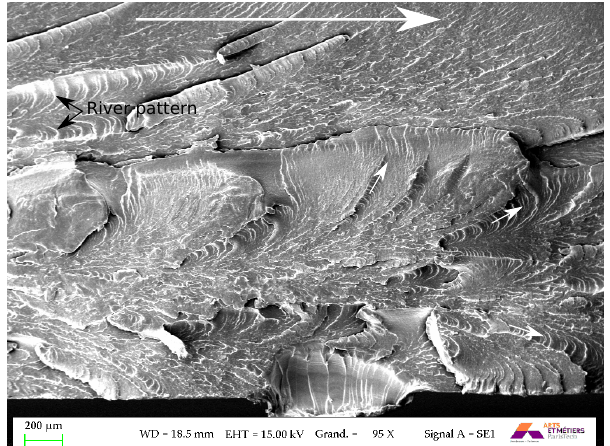
Figure 6. Observation by electron microscopy of the propagation zone of the fracture surface of sample B5. The large white arrow at the top indicates the main direction of propagation of the macrocrack front. The three small white arrows indicate the propagation directions of several microcracks. Characteristic river patterns in multi-phase polymers with high heterogeneity can be observed.